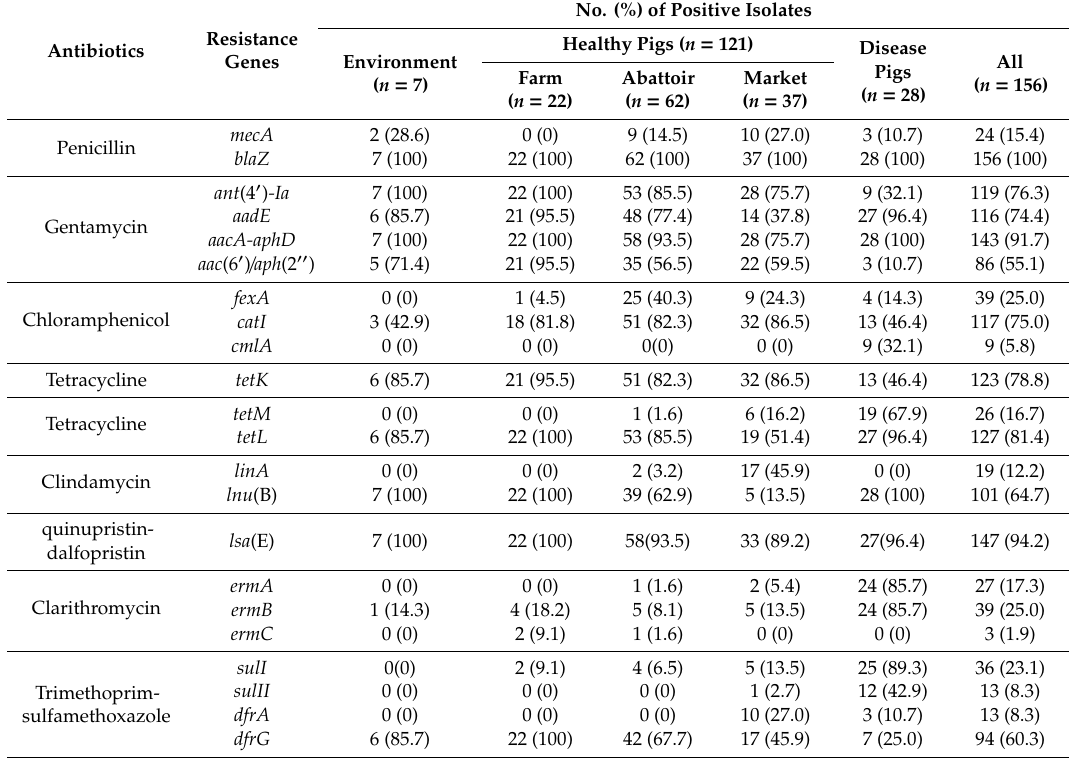
Table 2. Prevalence of antibiotic resistance associated genes among S. aureus